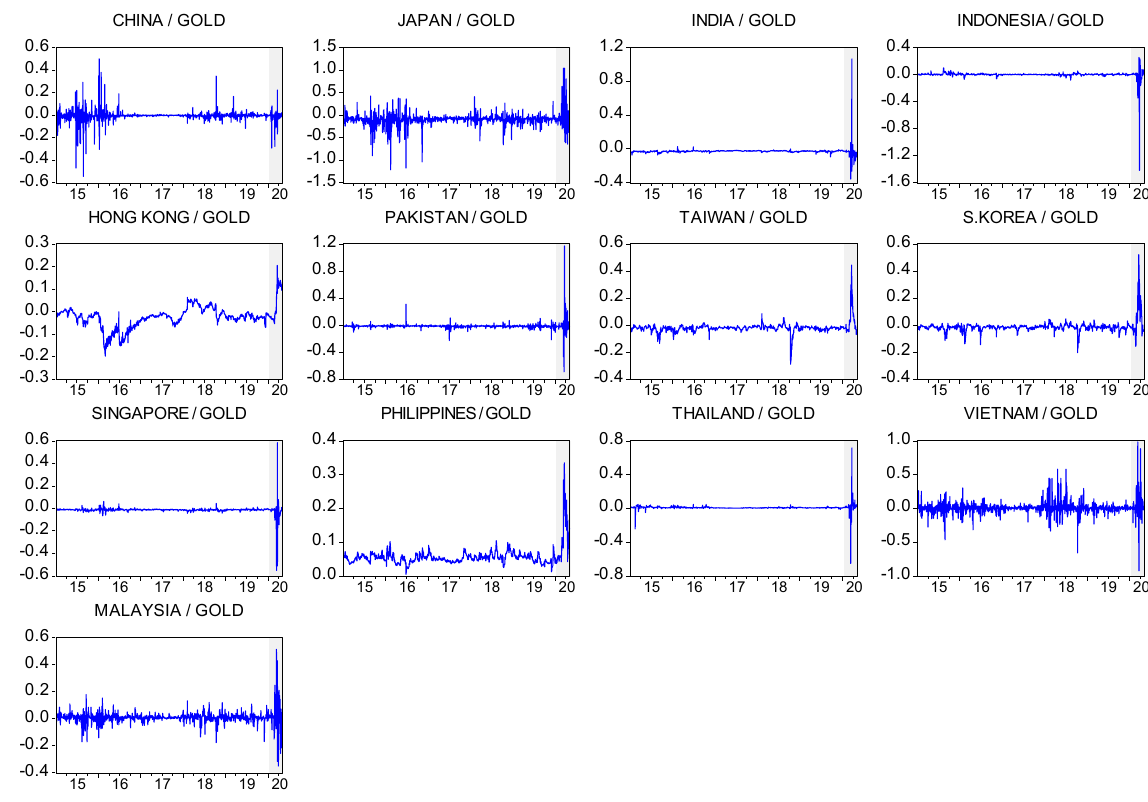
Figure 3. Optimal hedge ratios.